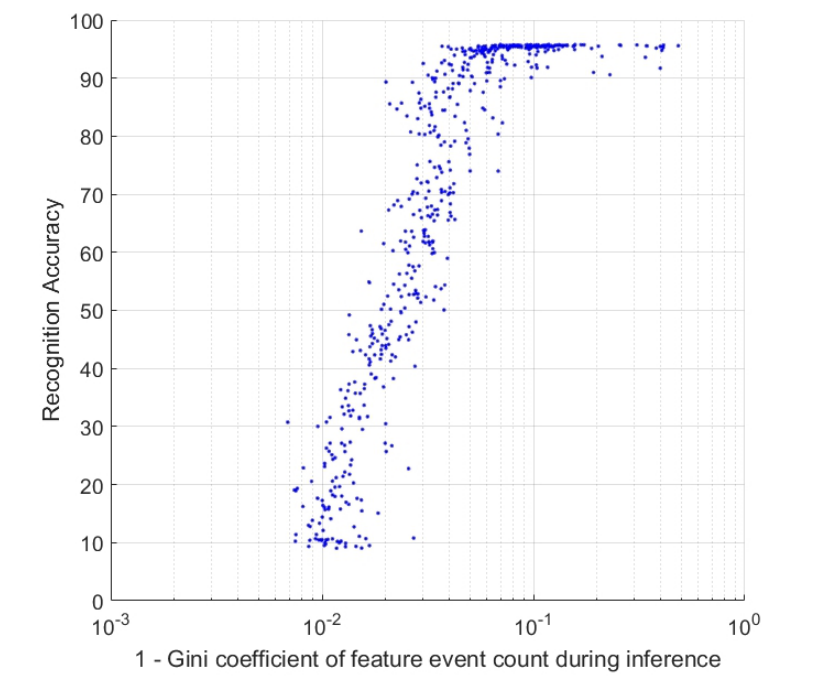
Figure 9. Final classification accuracy and the Gini coefficient of feature event counts. Each point on the plot represents results from an independent instantiation of a FEAST network with randomized parameters on random sections of the